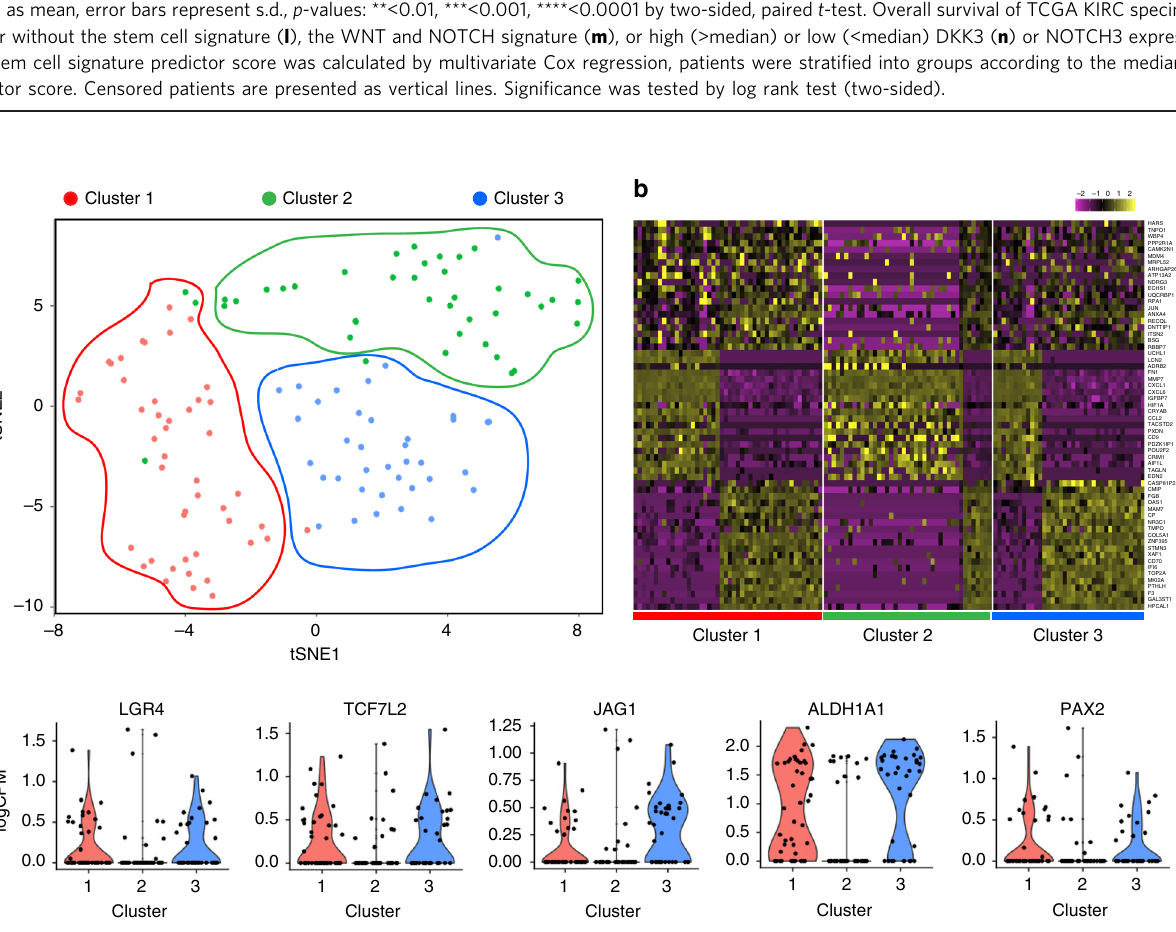
Fig. 5 Single-cell sequencing of CXCR4 + MET + CD44 + cells. Single-cell RNA-Seq was performed on 90 cells per patient by using the CEL-Seq2 method. Canonical cluster analysis was performed on common variable genes in the combined datasets, and tSNE clusters were subsequently identi fi ed. a tSNE plot of single cells, clusters marked in different colors, b Heatmap of the top 20 markers for each cluster. c Expression of WNT, NOTCH and stem cell marker genes in each cluster. Data are shown as scatter plot, violin plot represents data